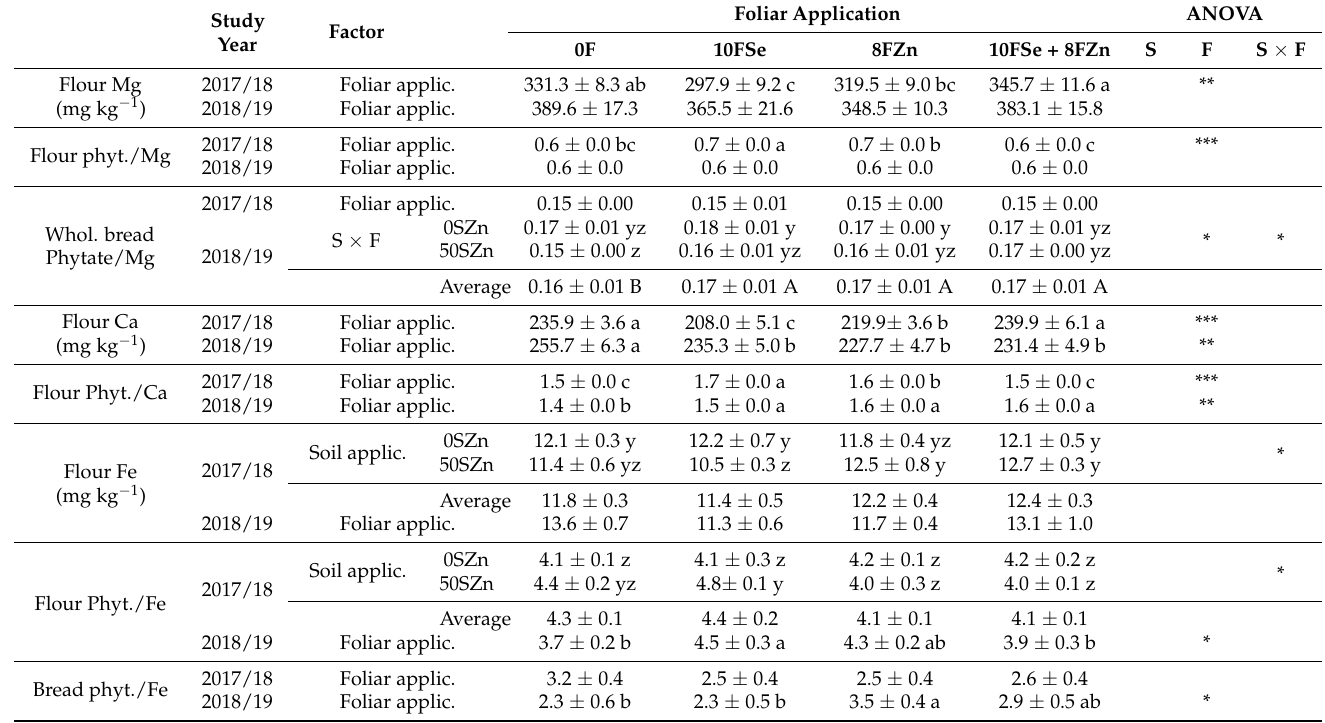
Table 3. Concentration of Mg, Ca and Fe, and their molar phytate:mineral ratios in white flour, wholemeal bread and white bread, expressed as mean value ± standard error ( n = 4 flour and = 2 for bread), as affected by the foliar application (F) and/or by its interaction with soil Zn application. Levels of significance (* p ≤ 0.05, ** p ≤ 0.01, *** p ≤ 0.001) for main effects (Zn soil application and foliar application) and interactions according to ANOVAs are also shown.